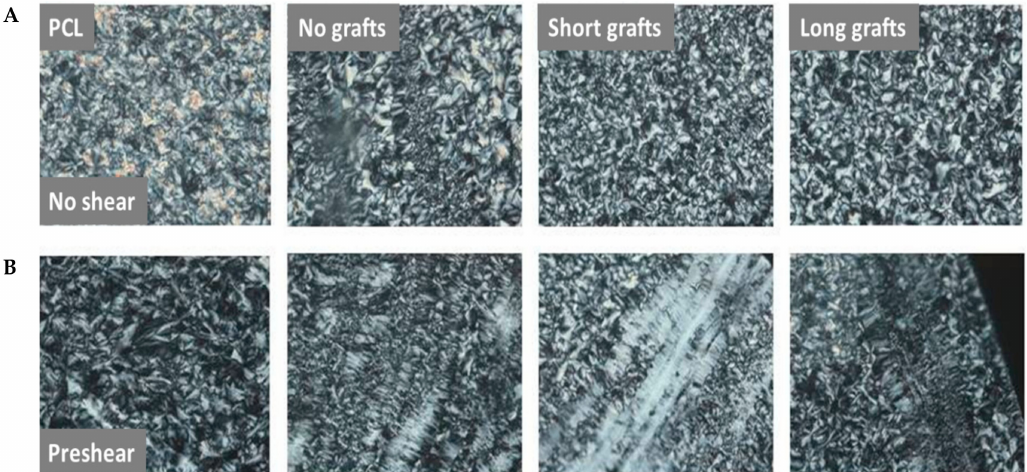
Figure 15. POM images of di ff erent samples after crystallisation under di ff erent conditions without applied shear ( A ) and with an applied shear of 30 s − 1 for 3 sec ( B ). Composite samples were based on the PCL40 matrix and contained 1 wt% filler. From left to right: neat PCL, composites with silica particles with no grafts, shorts grafts, long